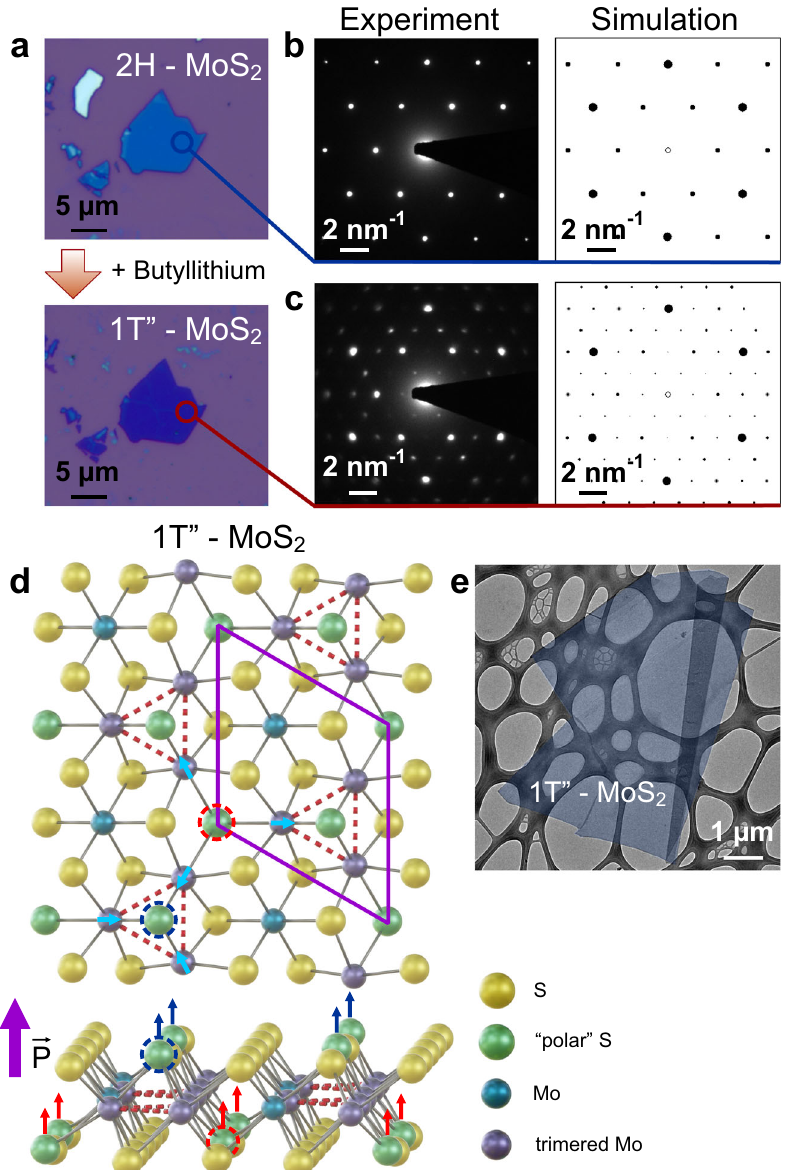
Fig. 1 Synthesis and structural characterization of 1T ” -MoS 2 fl akes. a MoS 2 fl ake on Si/SiO 2 substrate before and after the treatment with tert -butyllithium. b , c Experimental SAED patterns of the MoS 2 fl akes before ( b ) and after ( c ) the lithiation treatment and the